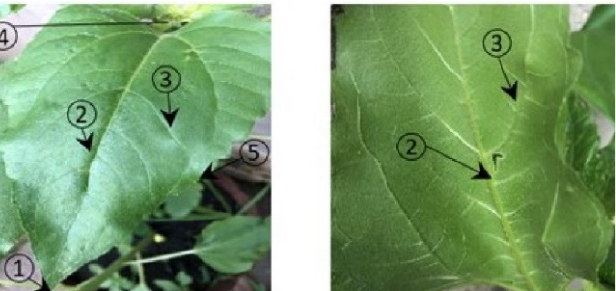
Figure 1. Leaf parts on the upper and lower side. ( 1 ) apex; ( 2 ) midvein (primary vein); ( 3 ) secondary vein; ( 4 ) lamina; ( 5 ) leaf margin.